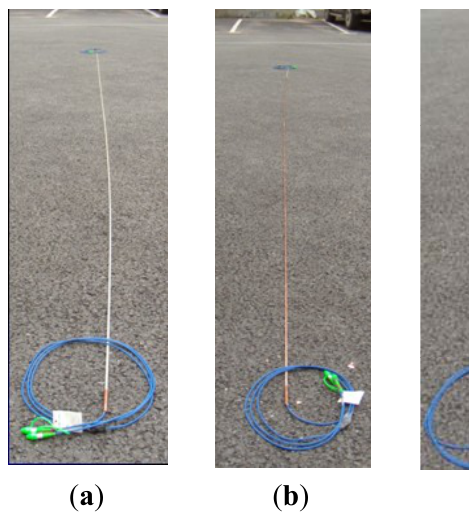
Figure 4. Photos of manufacturing the smart steel strand. ( a ) The rebar; (b ) Winded the coil; and ( c ) Assemble the smart